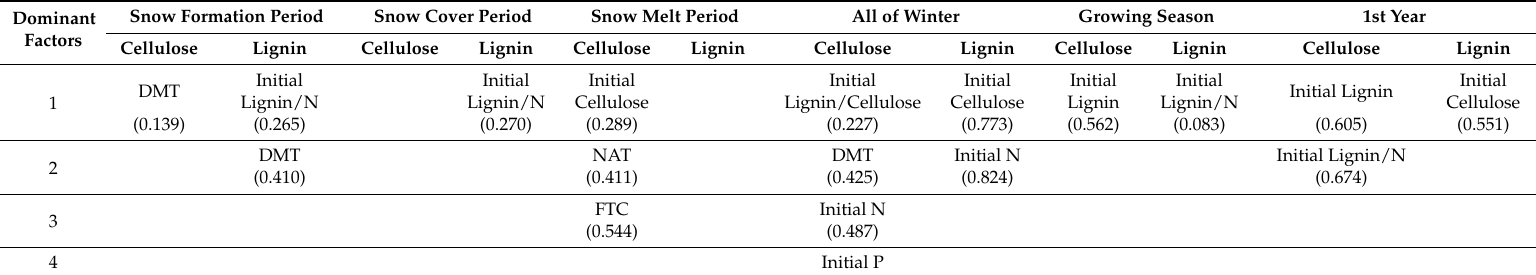
Table 4. Dominant factors and coefficients of determination ( R 2 ) for step-wise regression analysis of litter cellulose and lignin absolute change percentages affected by environmental factors (DMT, daily mean temperature; PAT, positive accumulated temperature; NAT, negative accumulated temperature; FTC, frequency of freeze-thaw cycles per day) and initial litter quality (initial C, N, P, cellulose, lignin, C/N, C/P, N/P, lignin/N, lignin/cellulose) for each decomposition period over the first year of litter decomposition in an alpine Minjiang fir